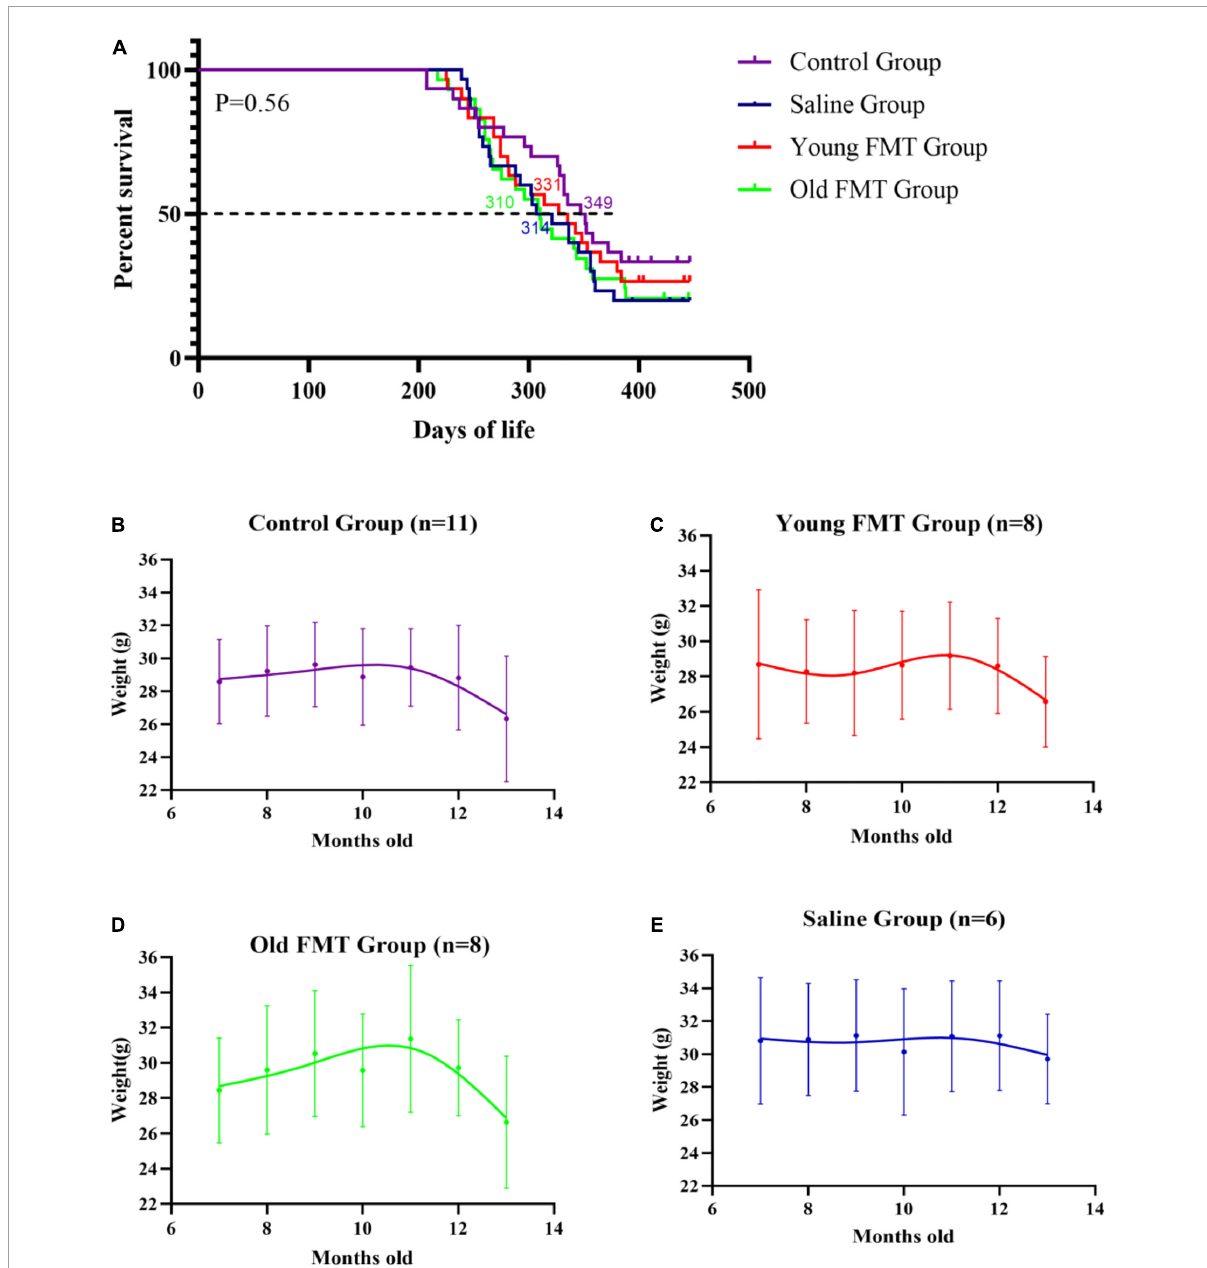
FIGURE3 Effects of fecal microbiota transplantation on lifespan and weight change with aging. (A) Percentage survival of Senescence Accelerated Mouse-Prone 8 (SAMP8) mice in four groups. Differences were analyzed with the log-rank Mantel–Cox test. Median survival is indicated in the Kaplan–Meier plot. With the end of the study (13 ◦ months-old), the death events in Control group, Saline group, Young FMT group and Old FMT group were 20, 24, 22, and 23, respectively. (B) The longitudinal comparison of weight from 7 ◦ months old to 13 ◦ months old within control group ( n = 11). (C) The longitudinal comparison of weight from 7 ◦ months old to 13 ◦ months old within young FMT group ( n = 8). (D) The longitudinal comparison of weight from 7 ◦ months old to 13 ◦ months old within old FMT group ( n = 8). (E) The longitudinal comparison of weight from 7 ◦ months old to 13 ◦ months old within saline group ( n = 6). One-way repeated measures